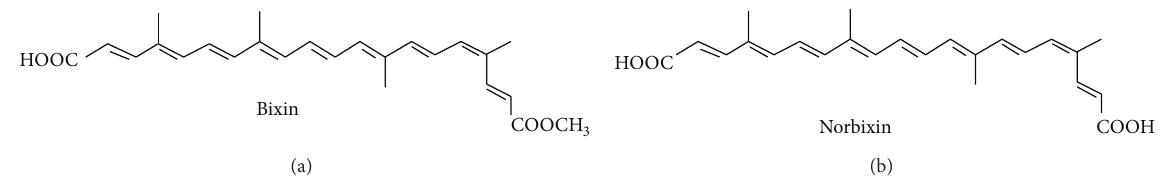
Figure 1: Chemical structure of annatto seed